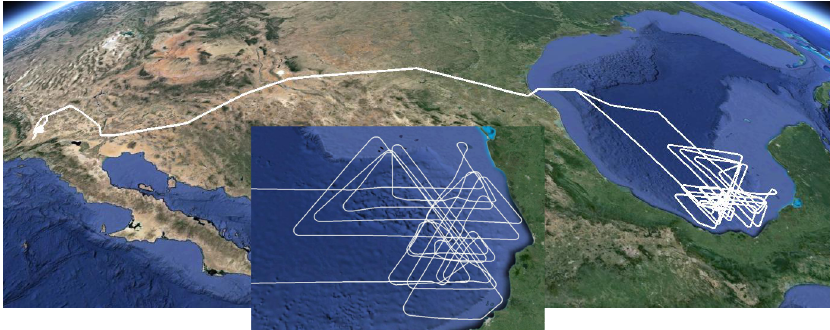
Figure 2. General view of NASA’s Global Hawk GRIP Mission